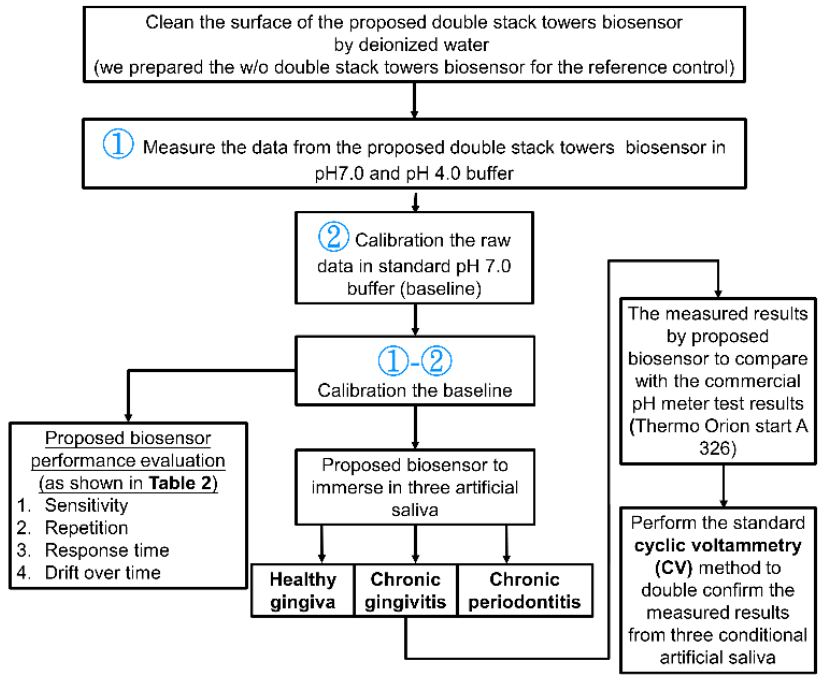
Figure 18. The calibration and measurement procedure for three artificial saliva, they are healthy gingiva, chronic gingivitis and chronic periodontitis, respectively. The measured result of proposed biosensor was also double confirmed by a commercial pH meter and cyclic voltammetry (CV) method to demonstrate the consistency of the